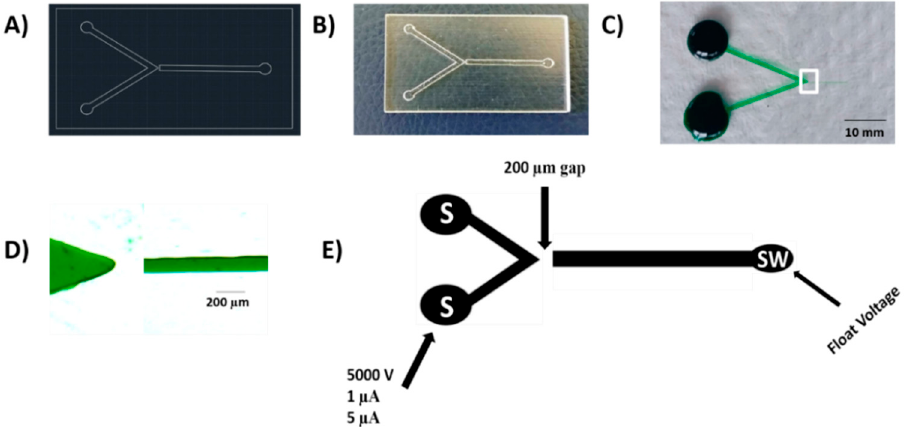
Figure 1. ( A ) An AutoCAD design of the filtration device ( B ) photograph image of the negative 3D printed portable device using an Eden 3D printer ( C ) Photograph image of the hot embossed filtration poly (methyl methacrylate) (PMMA)/adhesive tape device filled with green food dye. Scale bar = 10 mm. ( D ) Zoomed-in image of the V channel and the filtration channel (white box in panel C) filled with green food dye. Scale Bar = 200 µ m. ( E ) Schematic of the microfluidic device (dimension not to scale) indicating terminating current and voltages used for generation of the nano-junction Sample (S), and Sample Waste